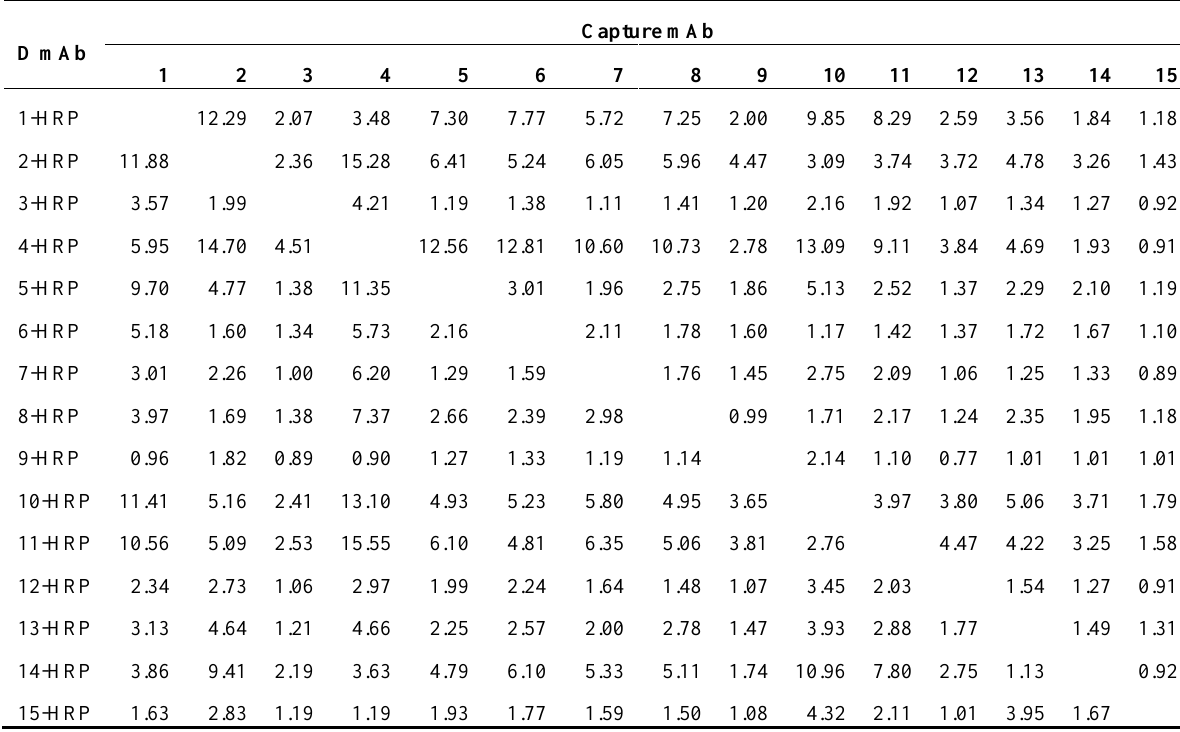
Table 1. Sandwich ELISA for pair-wise interaction analysis (P/N value). D